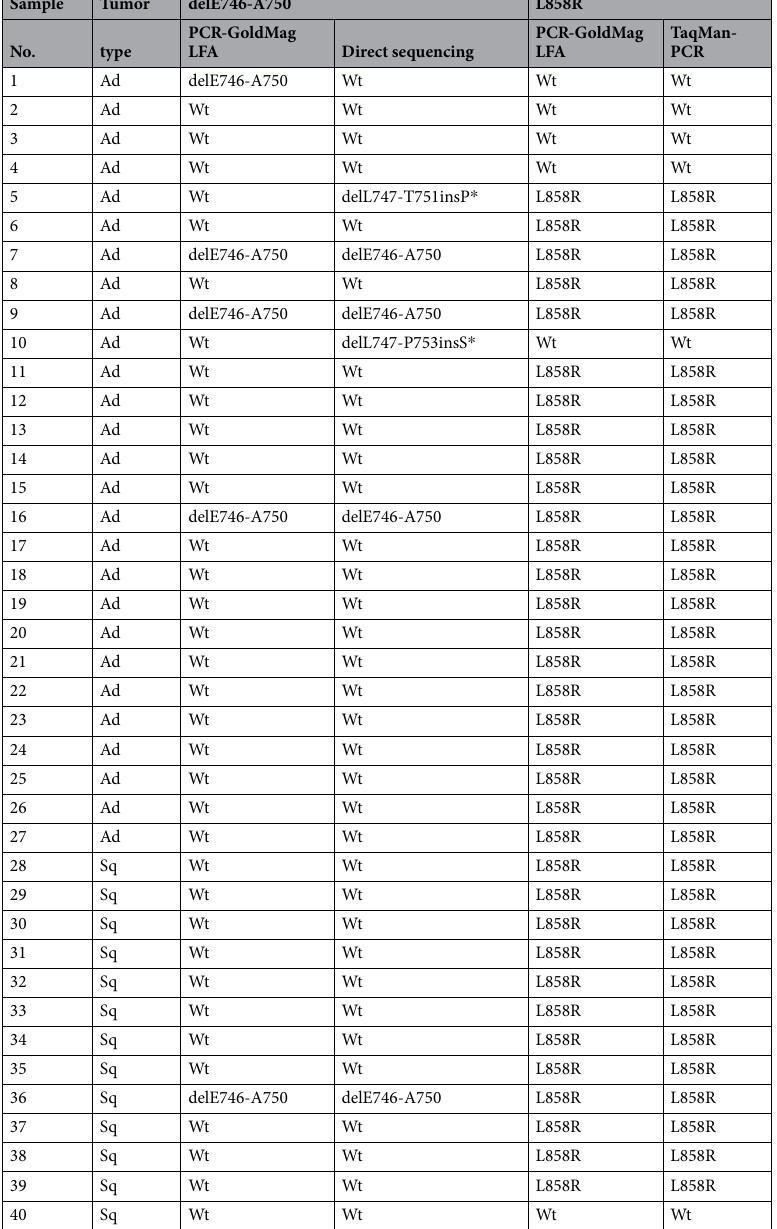
Table 1. Genotyping results by PCR-GoldMag LFA, DNA sequencing (delE746-A750) and TaqMan-PCR (L858R) for 40 FFPE clinical samples. Ad, adenocarcinoma; Sq, Squamous Cell Carcinomai; Del, deletions; Wt, wild type; * Rare exon 19 deletion mutations.